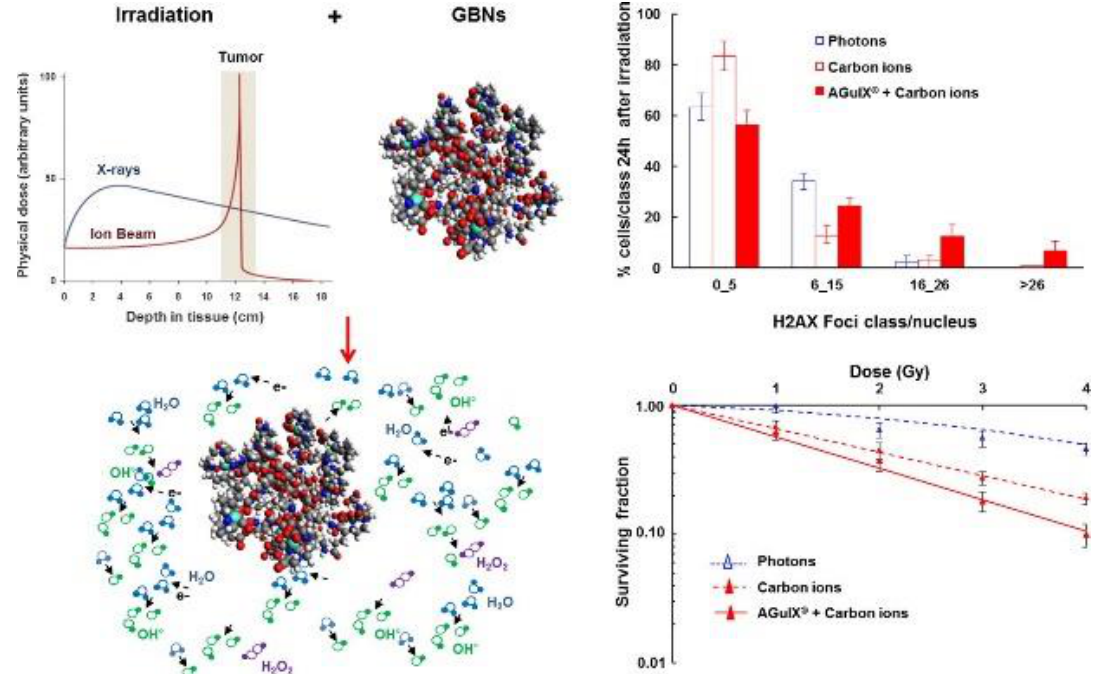
Figure 7. Representation of the AGuIX nanoparticle. Gadolinium-based nanoparticles AGuIX ® combined with photon or carbon ions exposure increase irreversible DNA double-strand breaks, leading to cell death in HNSCC cells, thus representing a promising alternative in hadrontherapy. Reprinted from [37], © 2017 with permission from Elsevier.